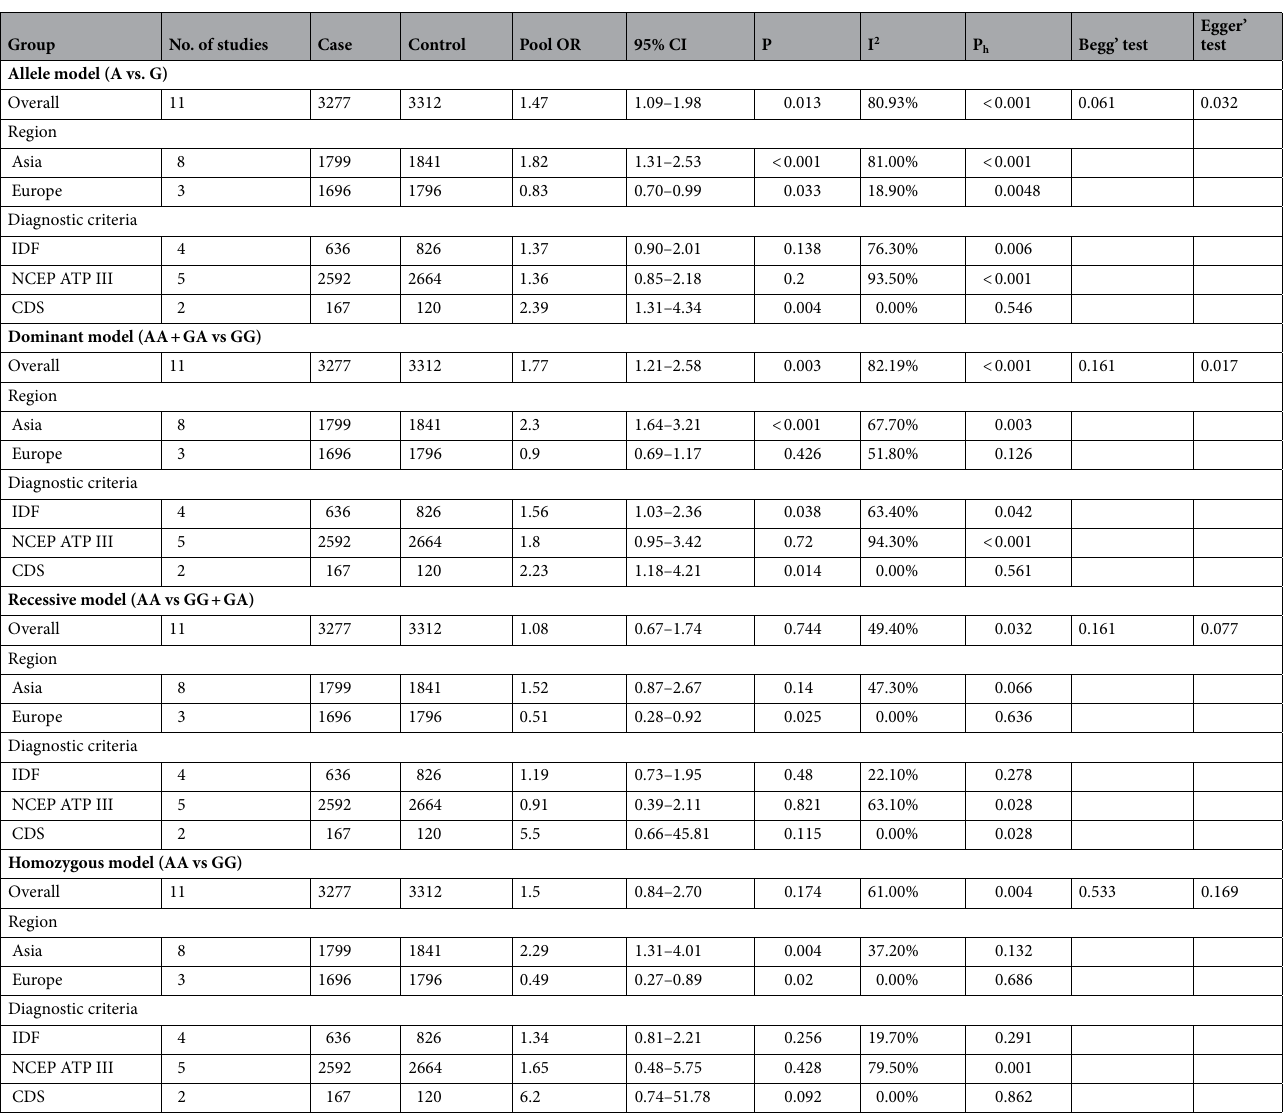
Table 2. The association between -308G/A polymorphism of TNF-α gene and MS susceptibility. IDF the International Diabetes Federation, NCEPATP III the National Cholesterol Education Program Adult Treatment Panel III, CDS Chinese Diabetes Society, OR odds ratio, CI confidence